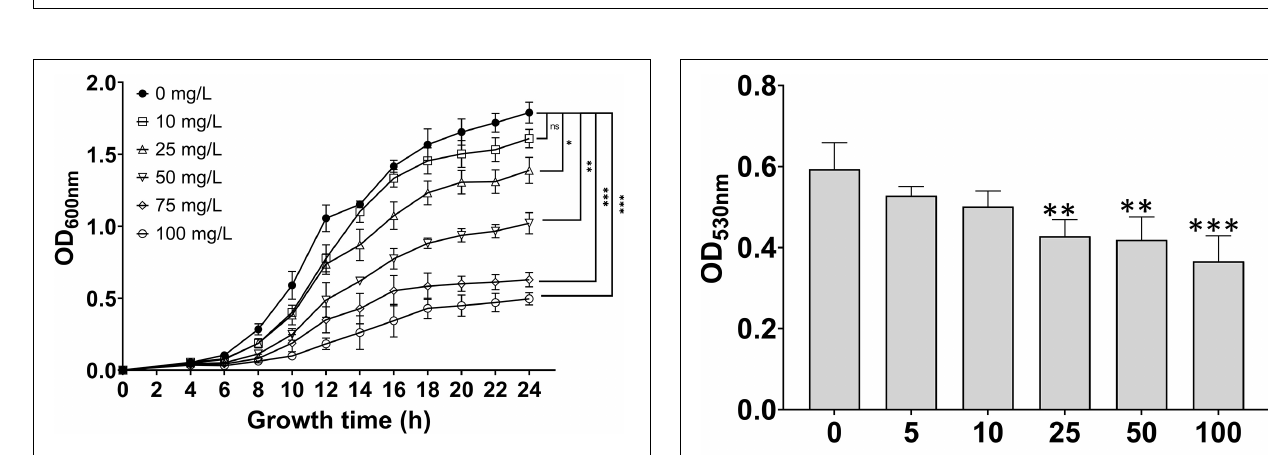
at concentrations of 25, 50, and 100 mg/L, respectively ( Supplementary Figure 1